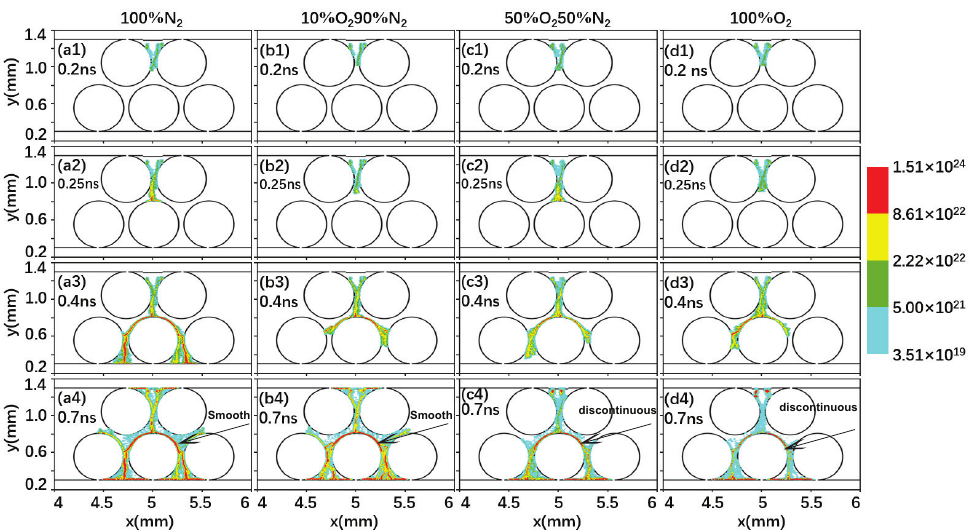
Figure 8. Electron density (m − 3 ) at 0.2, 0.25, 0.4 and 0.7 ns, for a driving voltage of − 20 kV, in a gas mixture of nitrogen and oxygen with different composition, ( a1 – a4 ) 100% N 2 , ( b1 – b4 ) 10% O 2 and 90% N 2 , ( c1 – c4 ) 50% O 2 and 50% N 2 , and ( d1 – d4 ) 100% O 2 . The same color scale is used in all panels to allow